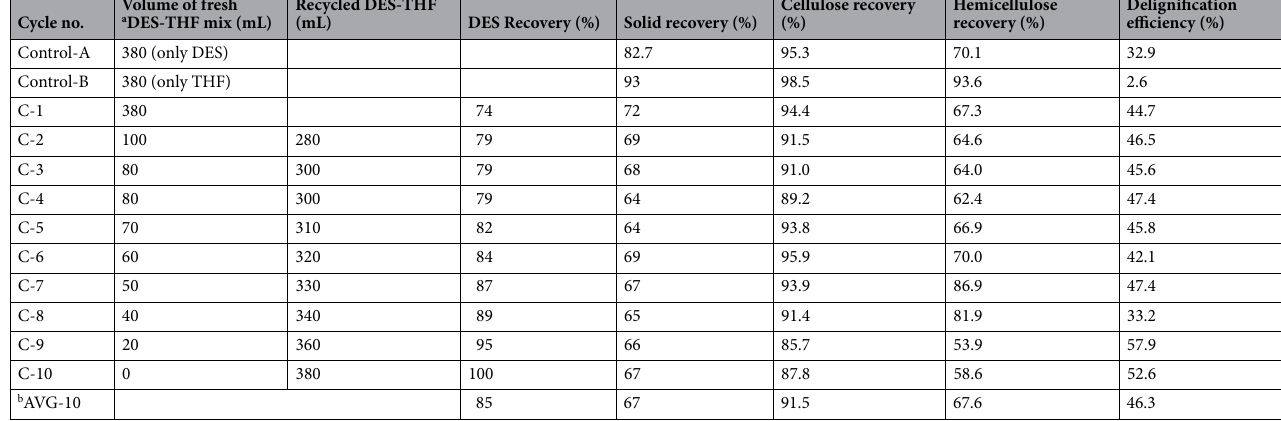
Table 3. Effect of recycling DES-THF solvent system on delignification, cellulose and hemicellulose recoveries during rice straw pretreatment (values presented are mean for n = 2 analyses). BDW (bone dry weight) of raw rice straw used in each cycle of pretreatment was 55 g (solids concentration ~ 15% w/v ). a The solvent mentioned above contains six parts of original DES and four parts of THF solvent. b AVG-10: average recoveries of DE-THF solvent, treated solids, cellulose, hemicellulose and average delignification efficiency over ten subsequent pretreatment